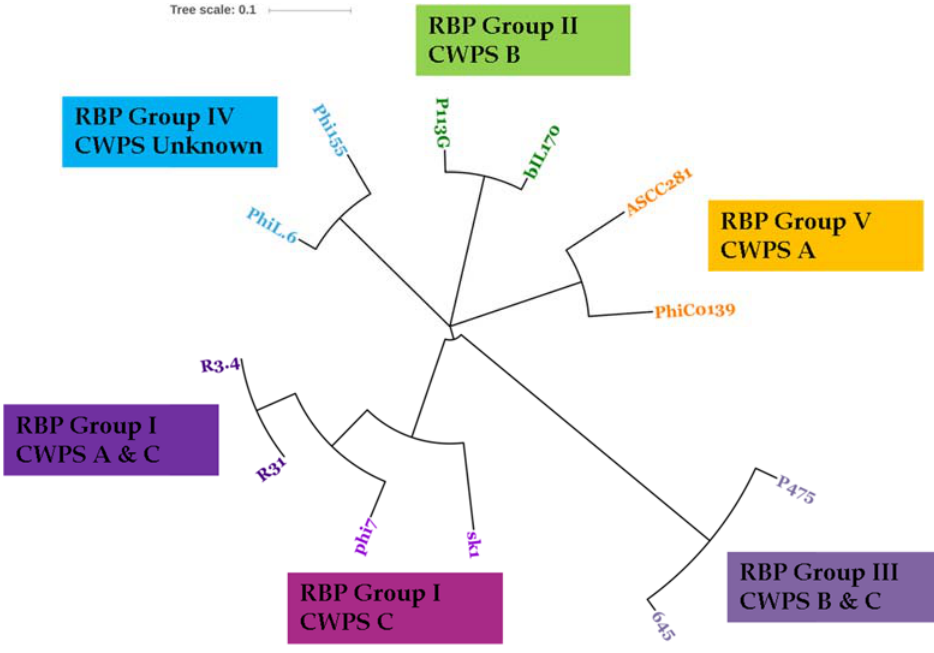
Figure 4. Unrooted phylogenetic tree of the RBP sequences of R31 and R3.4 and previously sequenced representative members of the five 936 RBP groups. R31 and R3.4 RBPs are identical to each other and occupy a distinct node within the RBP group I clade. The CWPS types of the host strains infected by these phages are presented along with the RBP grouping information.